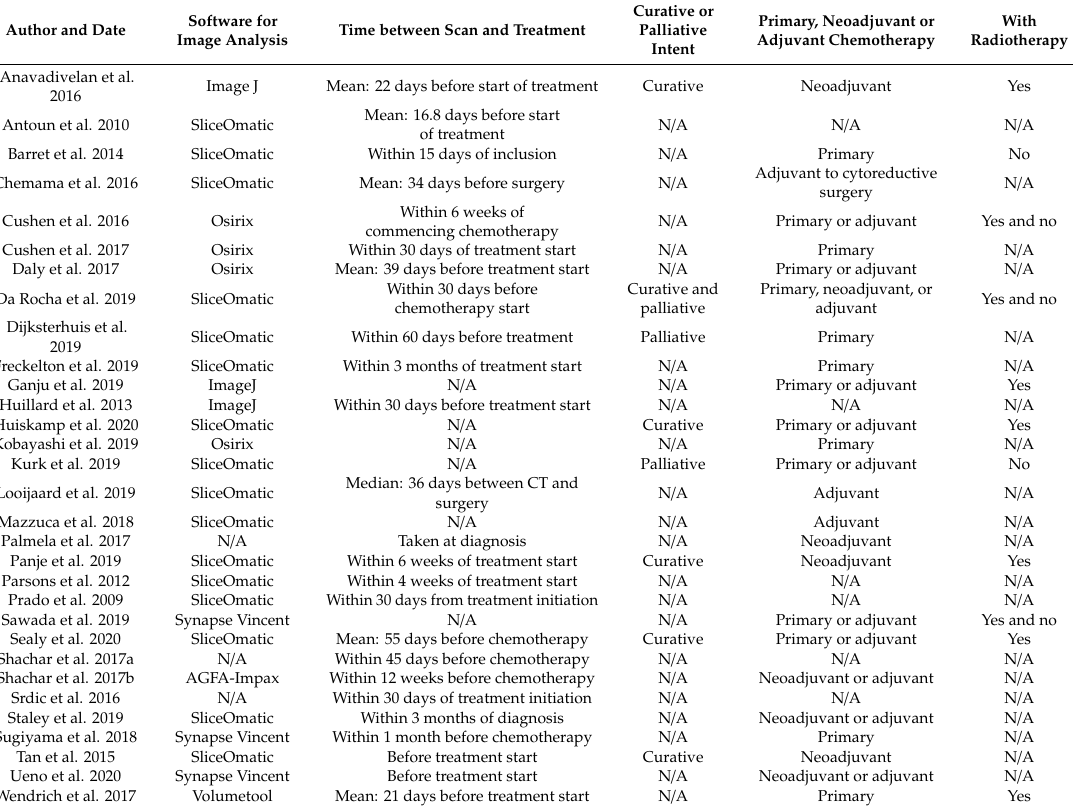
Table A1. Additional characteristics of included